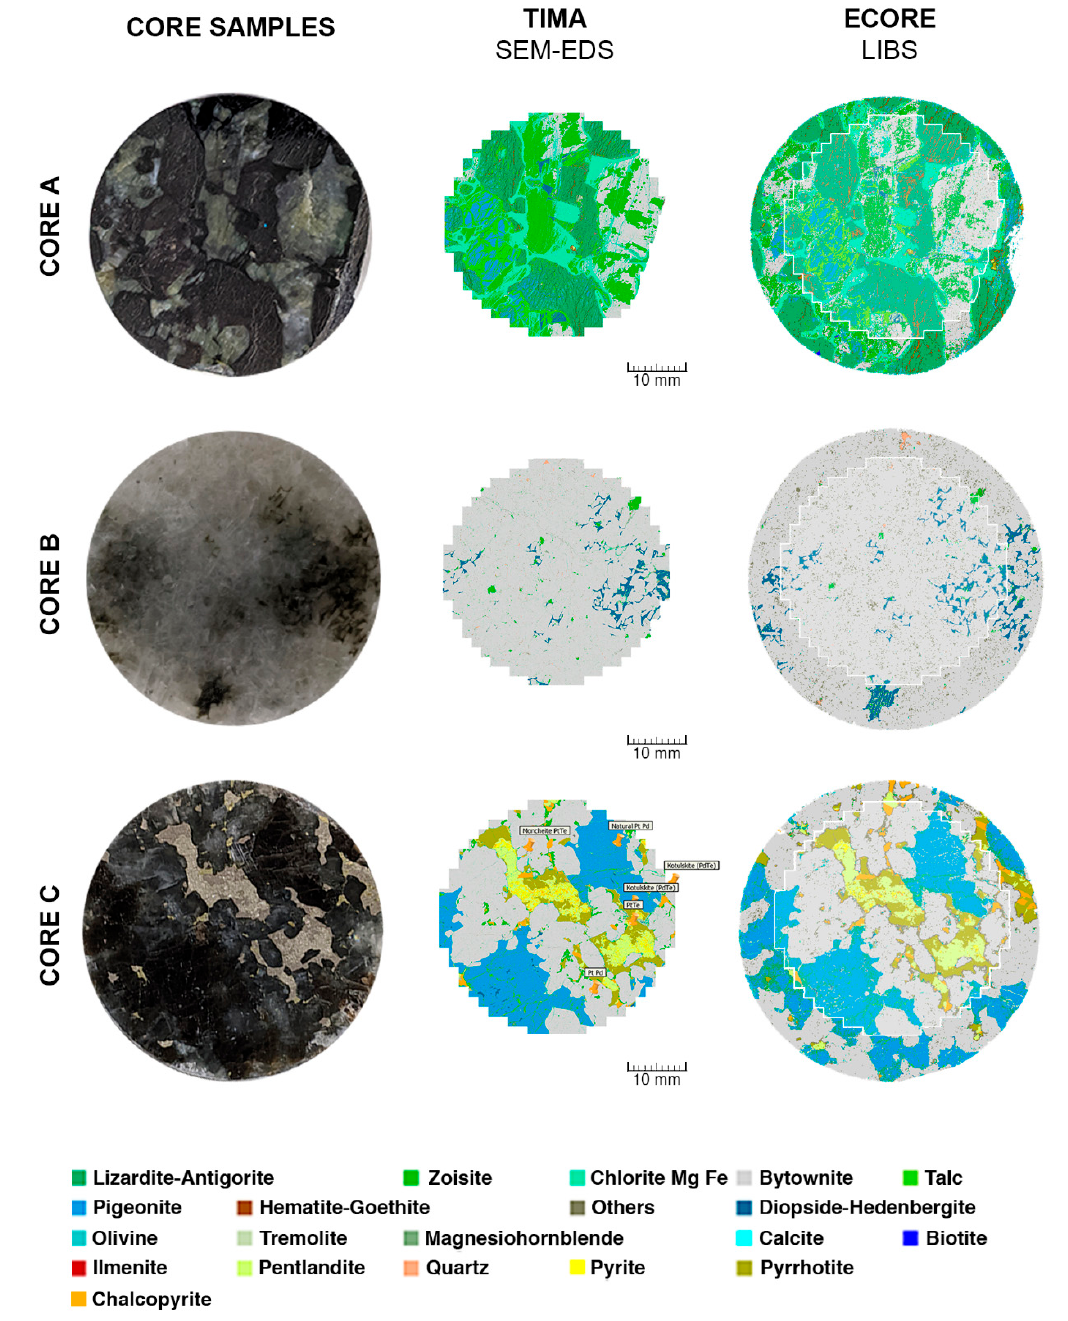
Figure 6. TIMA-X and ECORE mineral maps of core samples A, B, and C (the red circles in Figure 1).